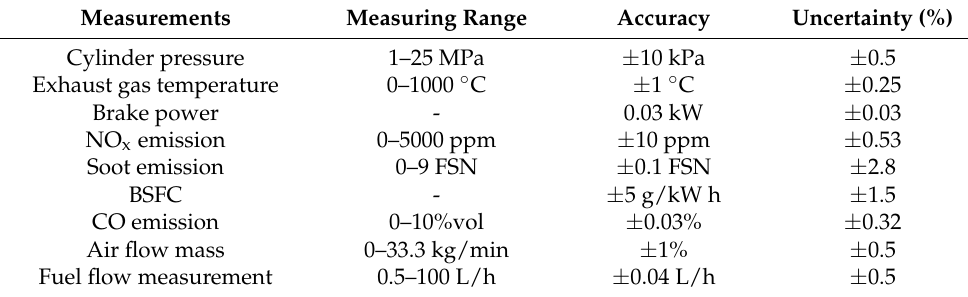
Figure 3. Schematic diagram of experimental device. Table 3. Lists of measurements, the measuring range, and accuracy.